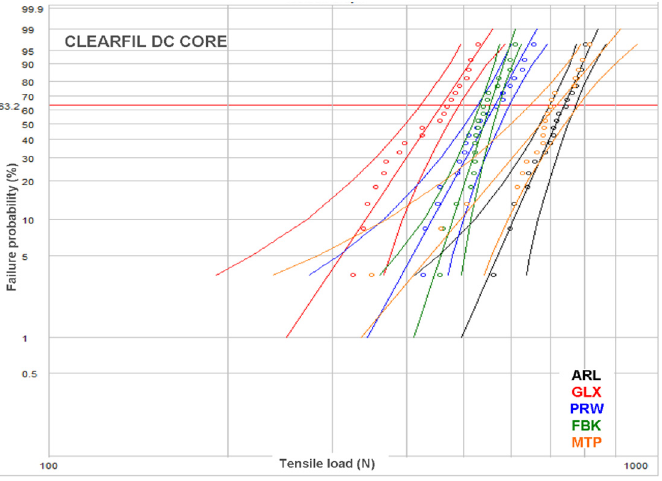
Figure 5. Weibull plot for the posts restored with CDC.